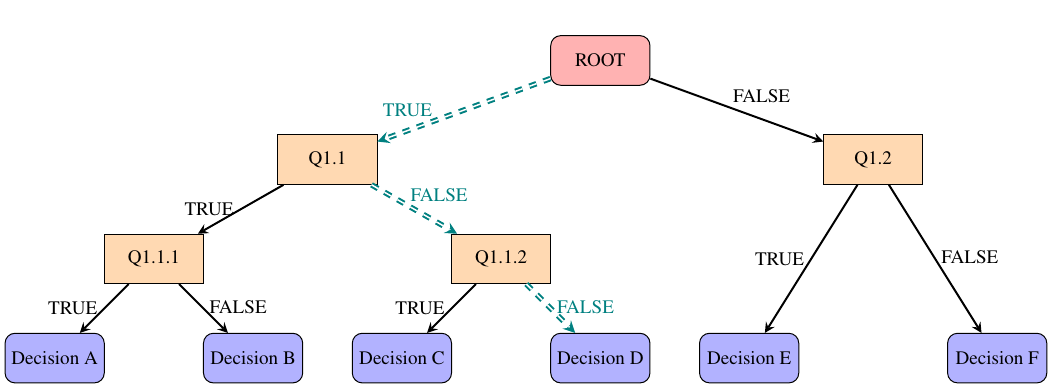
Figure 1. A binary tree—starting from the root node, multiple criteria are selected based on the Figure 1: A binary tree - starts from the root node, multiple criteria are selected based on the information from each input. A information from each input. A decision is drawn at a particular leaf, i.e., Decision D, if all criteria decision is drawn at a particular leaf, i.e. Decision D, if all criteria along its path “==” are satisfied . along its path “==” are Random forests 84